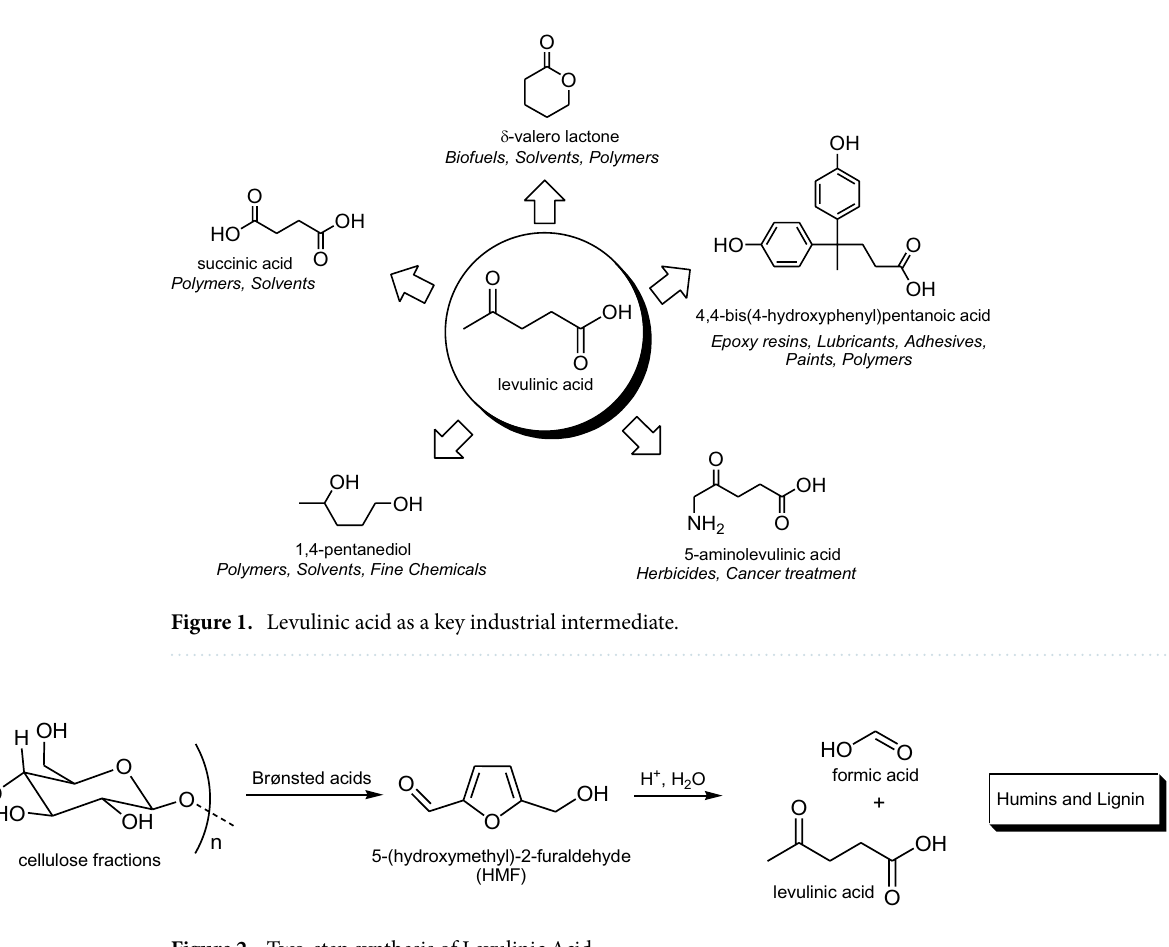
Figure 2. Two-step synthesis of Levulinic